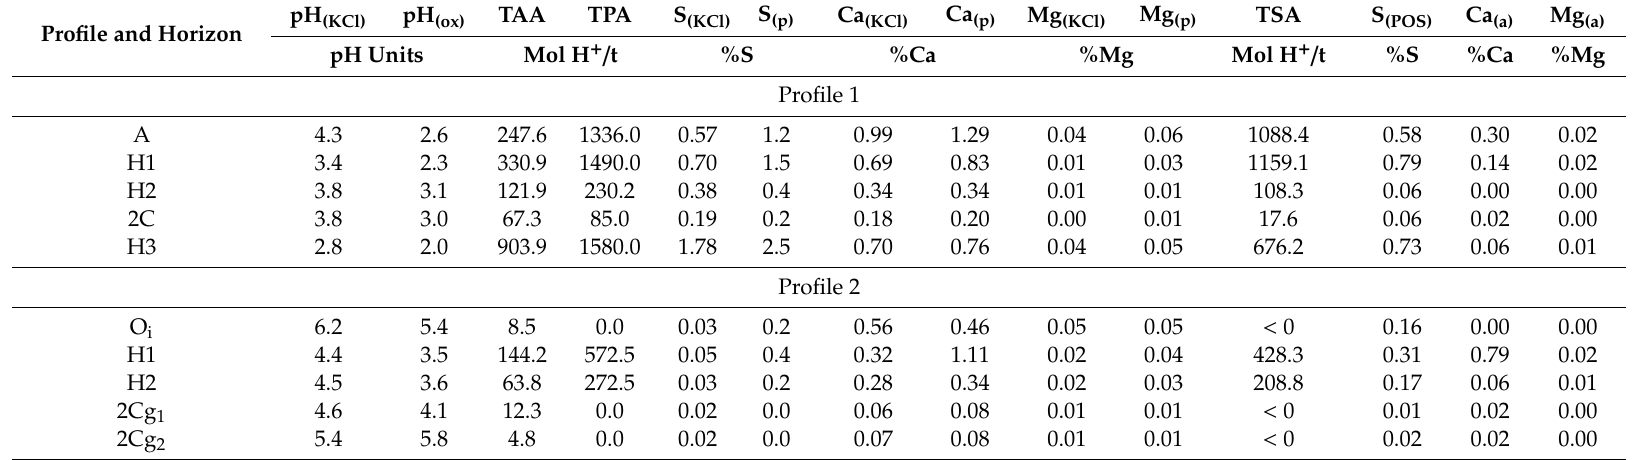
Table 4. SPOCAS results obtained in profiles 1 and 2. TAA: Titratable actual acidity; TPA: Titratable peroxide acidity; TSA: Titratable sulfidic acidity; S(POS): Peroxide oxidisable sulfur; (p): Peroxide; (a): Reactive. Profile and